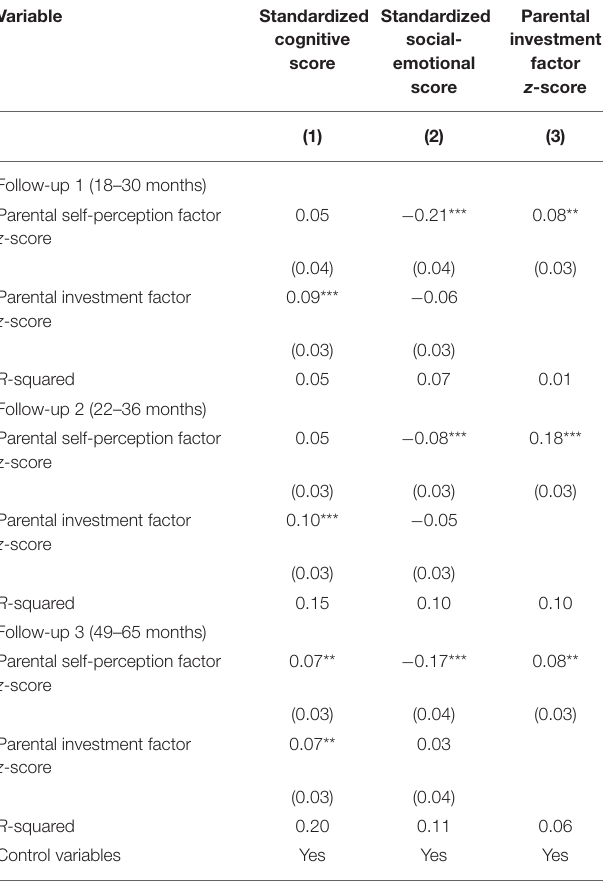
TABLE 4 | Associations between parental self-perception, parental investment and child developmental outcomes ( N = 815). Variable